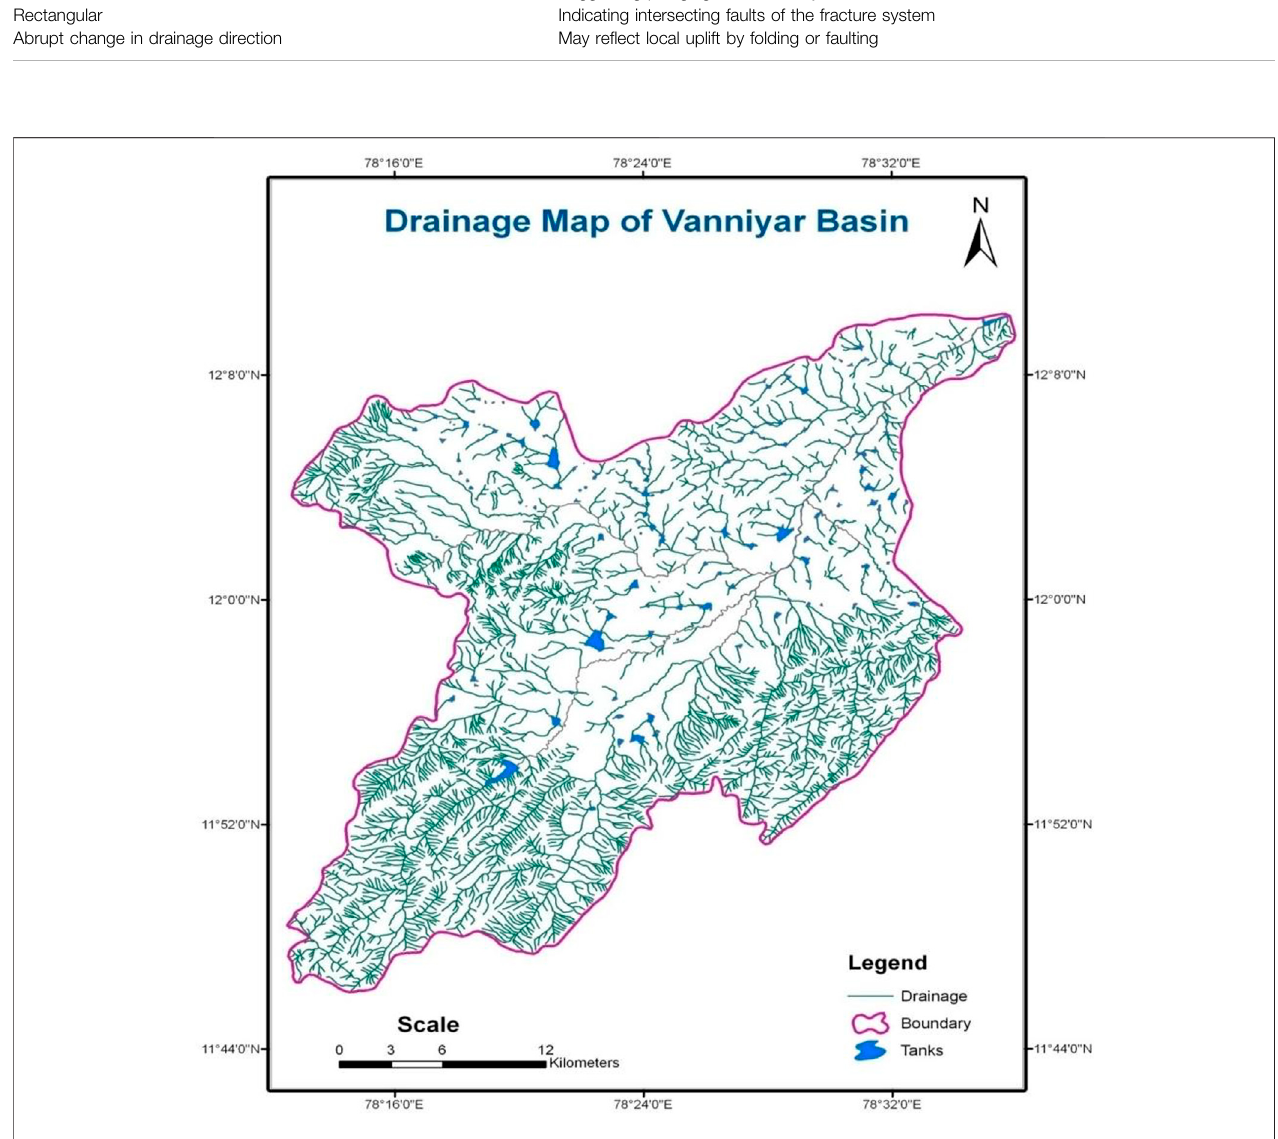
Frontiers in Remote Sensing |